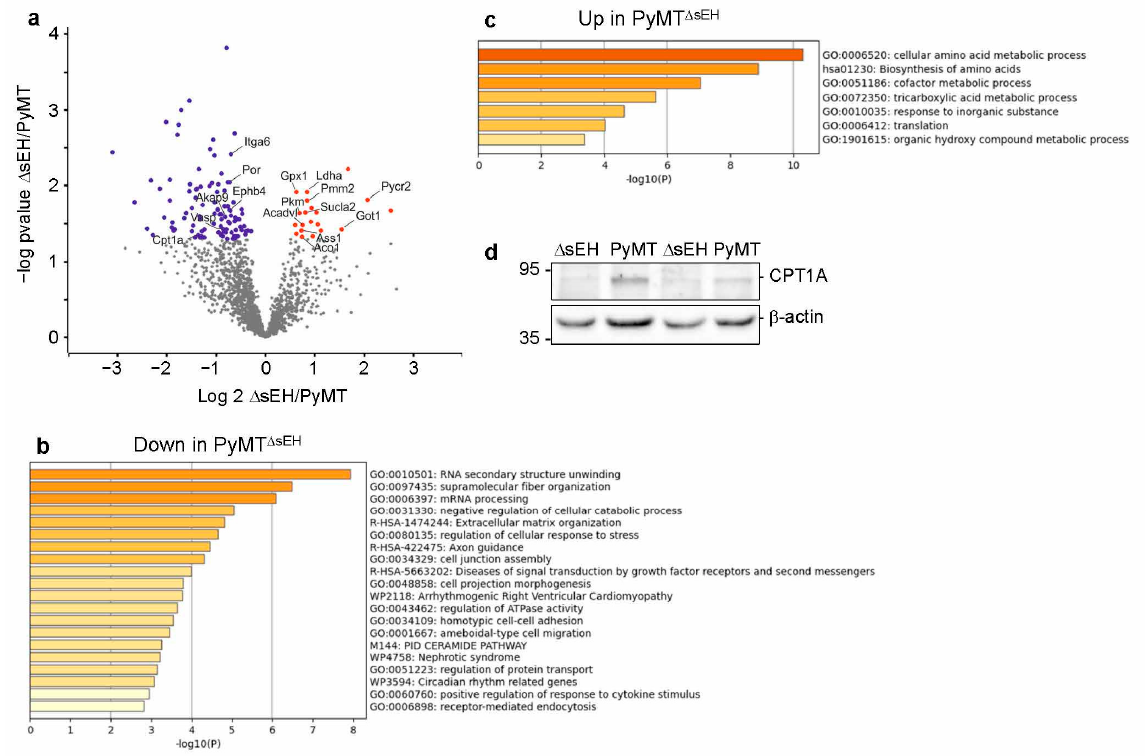
Figure 8. Altered protein expression in primary tumors from PyMT and PyMT ∆ sEH mice. ( a ) Volcano plot showing the proteins most altered in tumors from PyMT ∆ sEH ( ∆ sEH) versus PyMT mice. ( b , c ) Pathway analysis with enrichment scores for GO term annotations showing proteins downregulated ( b ) or upregulated ( c ) in sEH-deficient tumors. ( d ) CPT1A expression in primary tumors from PyMT and PyMT ∆ sEH mice.